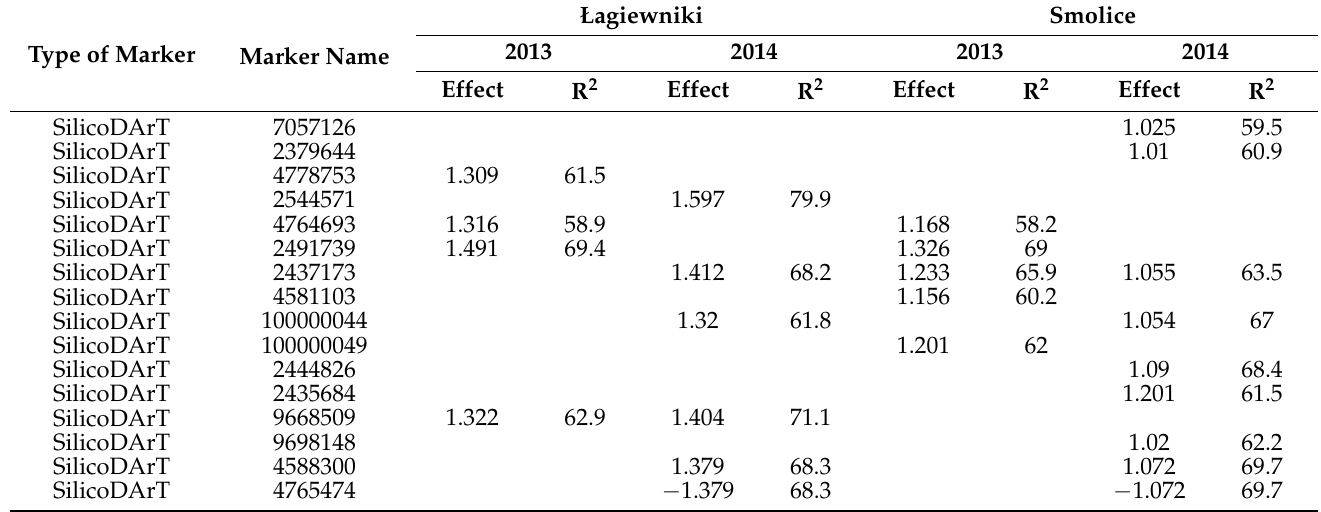
Table 5. Molecular markers associated (LOD > 3.0) with the heterosis effect of the number of rows of grain